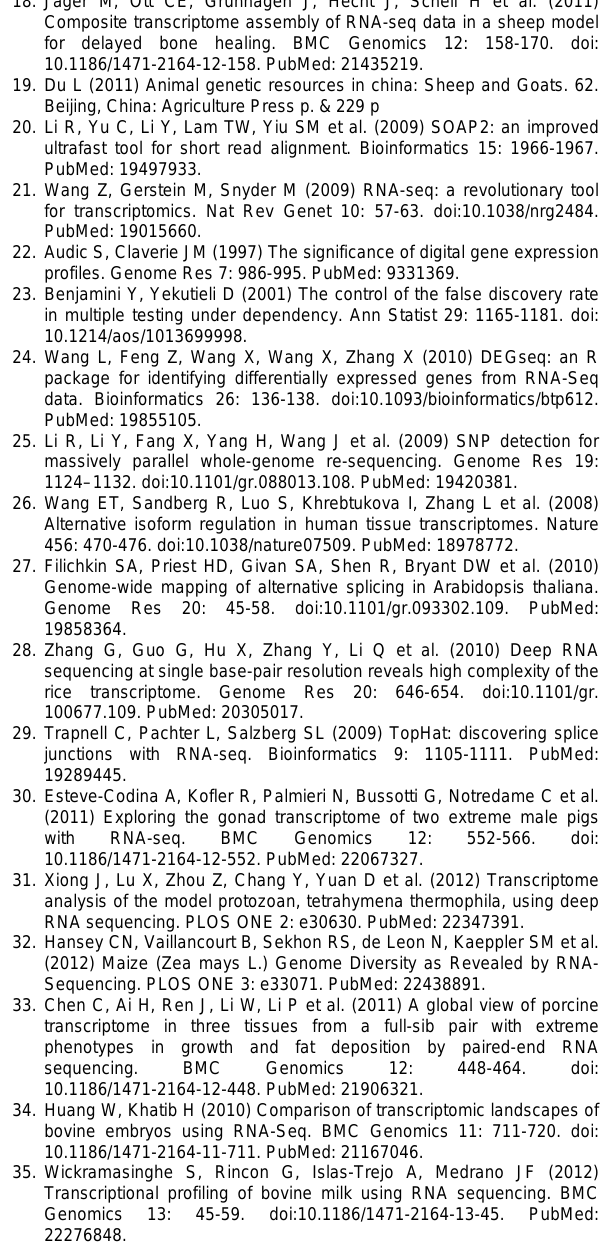
Table S6. Gene extension according to the transcripts from the DP and SH.